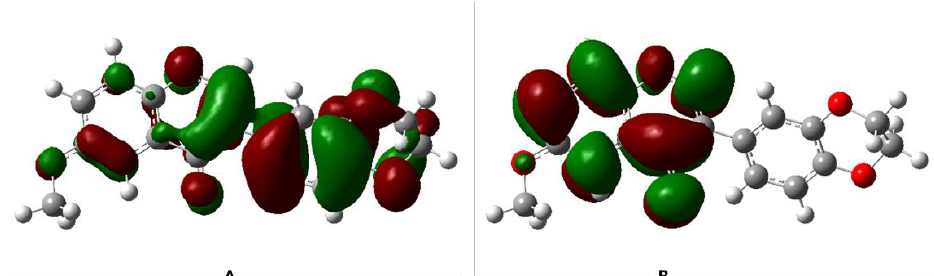
Figure 8. Molecular orbital surfaces of HOMO ( A ) and LUMO ( B ).